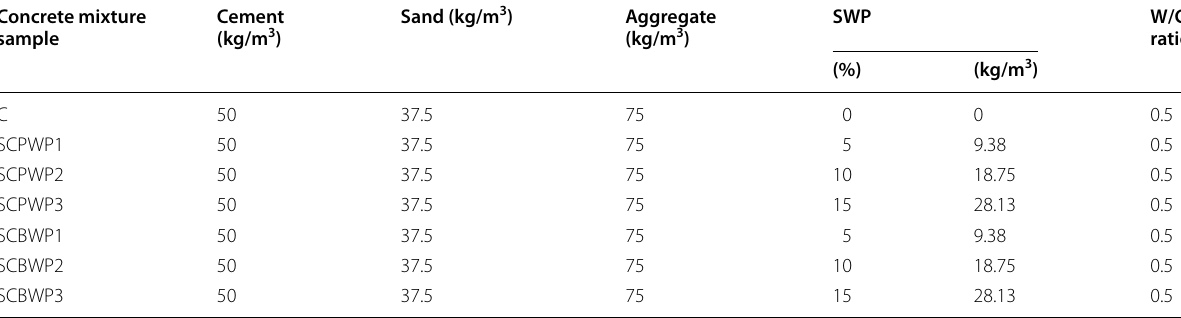
Table 3 Grade 30 proportion Concrete mixture